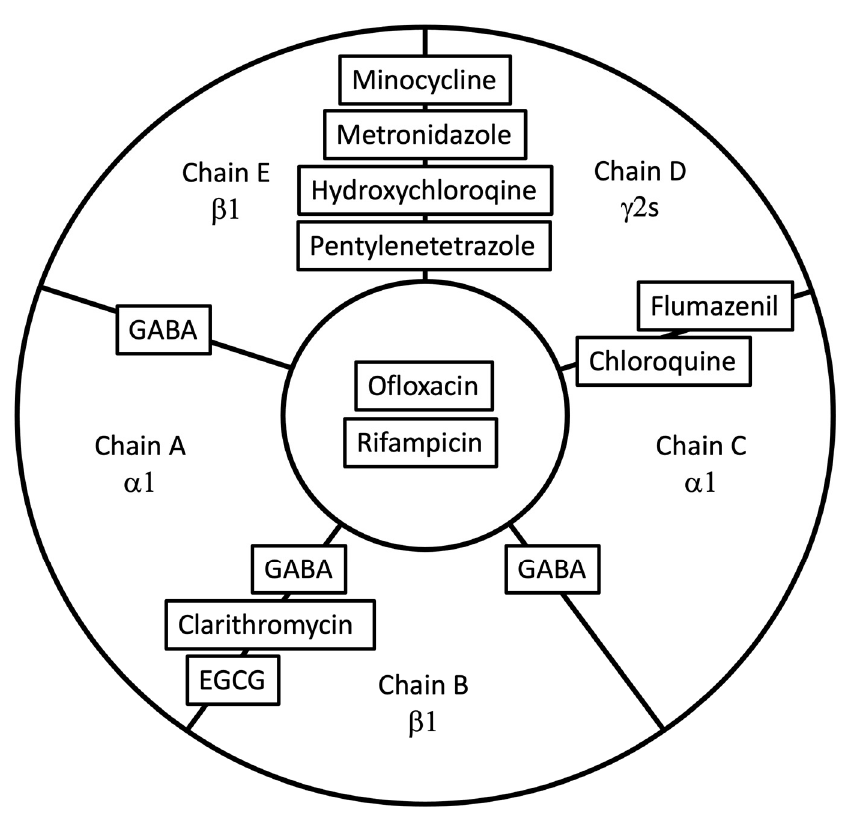
Figure 9. Cartoon of the predicted binding pockets of the compounds used in this study on the GABA A R extracellular surface, as viewed from a synapse. No modulators were predicted to act at the 2 canonical ( αβ ) GABA binding sites. Clarithromycin and EGCG are predicted to act at the βα GABA binding site. Flumazenil and chloroquine both docked at the canonical benzodiazepine γα binding site. Minocycline (data not shown), metronidazol, hydroxychloroquine, and pentylenetetrazole were all predicted to interact with the orphan βγ binding site. Finally, ofloxacin and rifampicin were docked in the extracellular lumen. Table 2. In silico modeling parameters for docking 11 compounds to the 6DW0.pdb GABA A receptor structure.